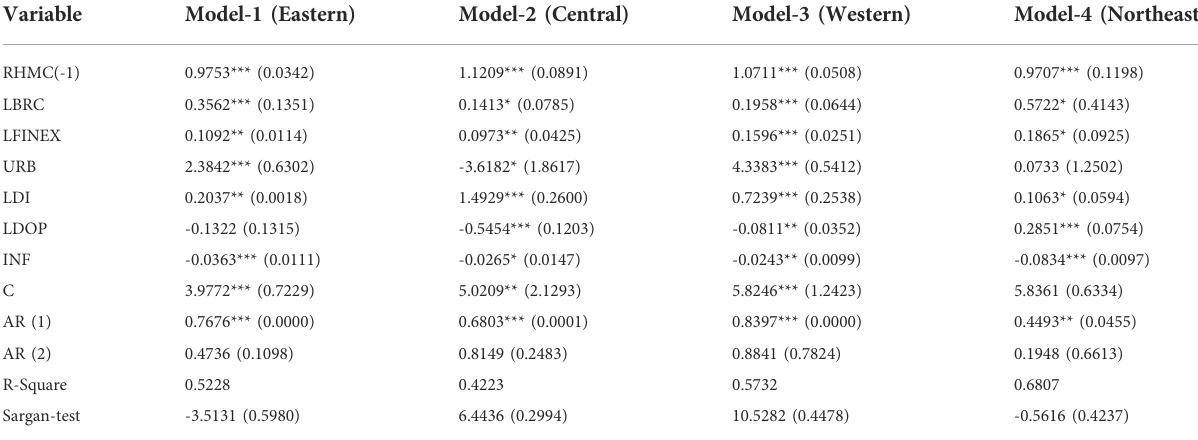
TABLE 9 Results of systematic GMM estimation of the effect of coverage breadth on rural human capital accumulation in different regions.